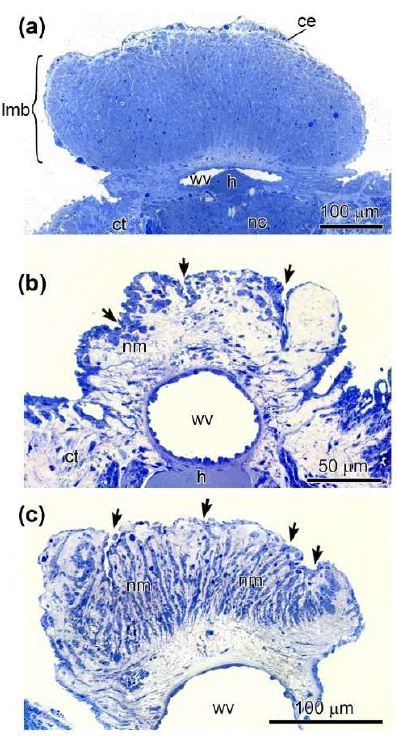
Figure 2. Transverse semithin sections of LMB at different stages after cutting of a holothurian, E. fraudatrix . ( a ) Undamaged LMB. ( b ) The LMB at 10th dpd (first stage of regeneration). ( c ) The LMB at 20th dpd (second stage of regeneration). ce, coelomic epithelium; ct, connective tissue of the body wall; h, hemal lacuna; lmb, longitudinal muscle band; nc, radial nerve cord; nm, new muscle bundles; wv, radial water-vascular canal; arrows indicate the sites of immersion of myogenic cells in the connective